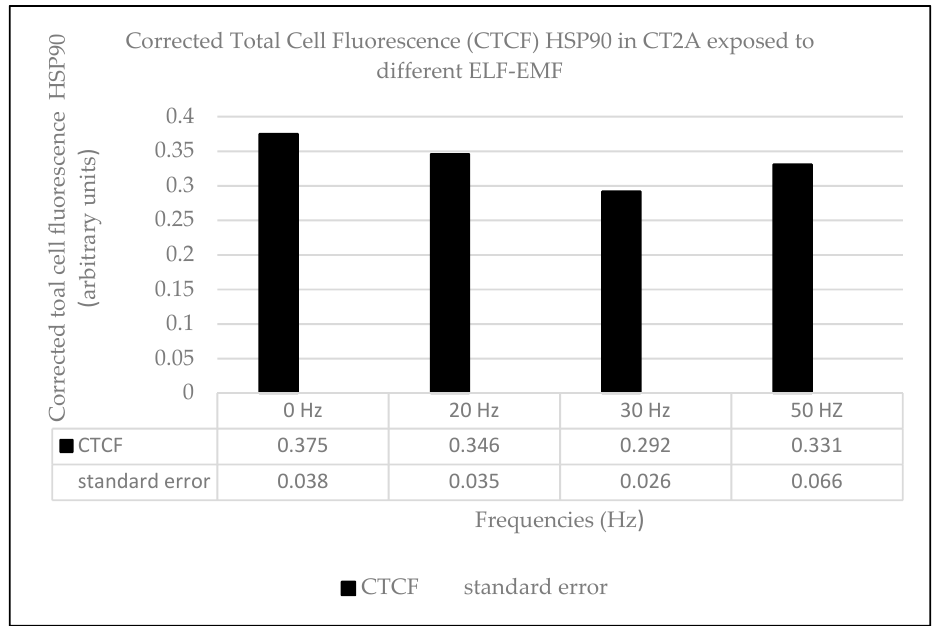
Figure 5. Corrected total cell fluorescence. Average corrected total cell fluorescence (CTCF) of HSP90 expression in CT2A control group (0 Hz, non-exposed) and CT2A cells after 24 h of exposure to a 100 μ T EMF at different ELF: 20, 30, and 50 Hz .